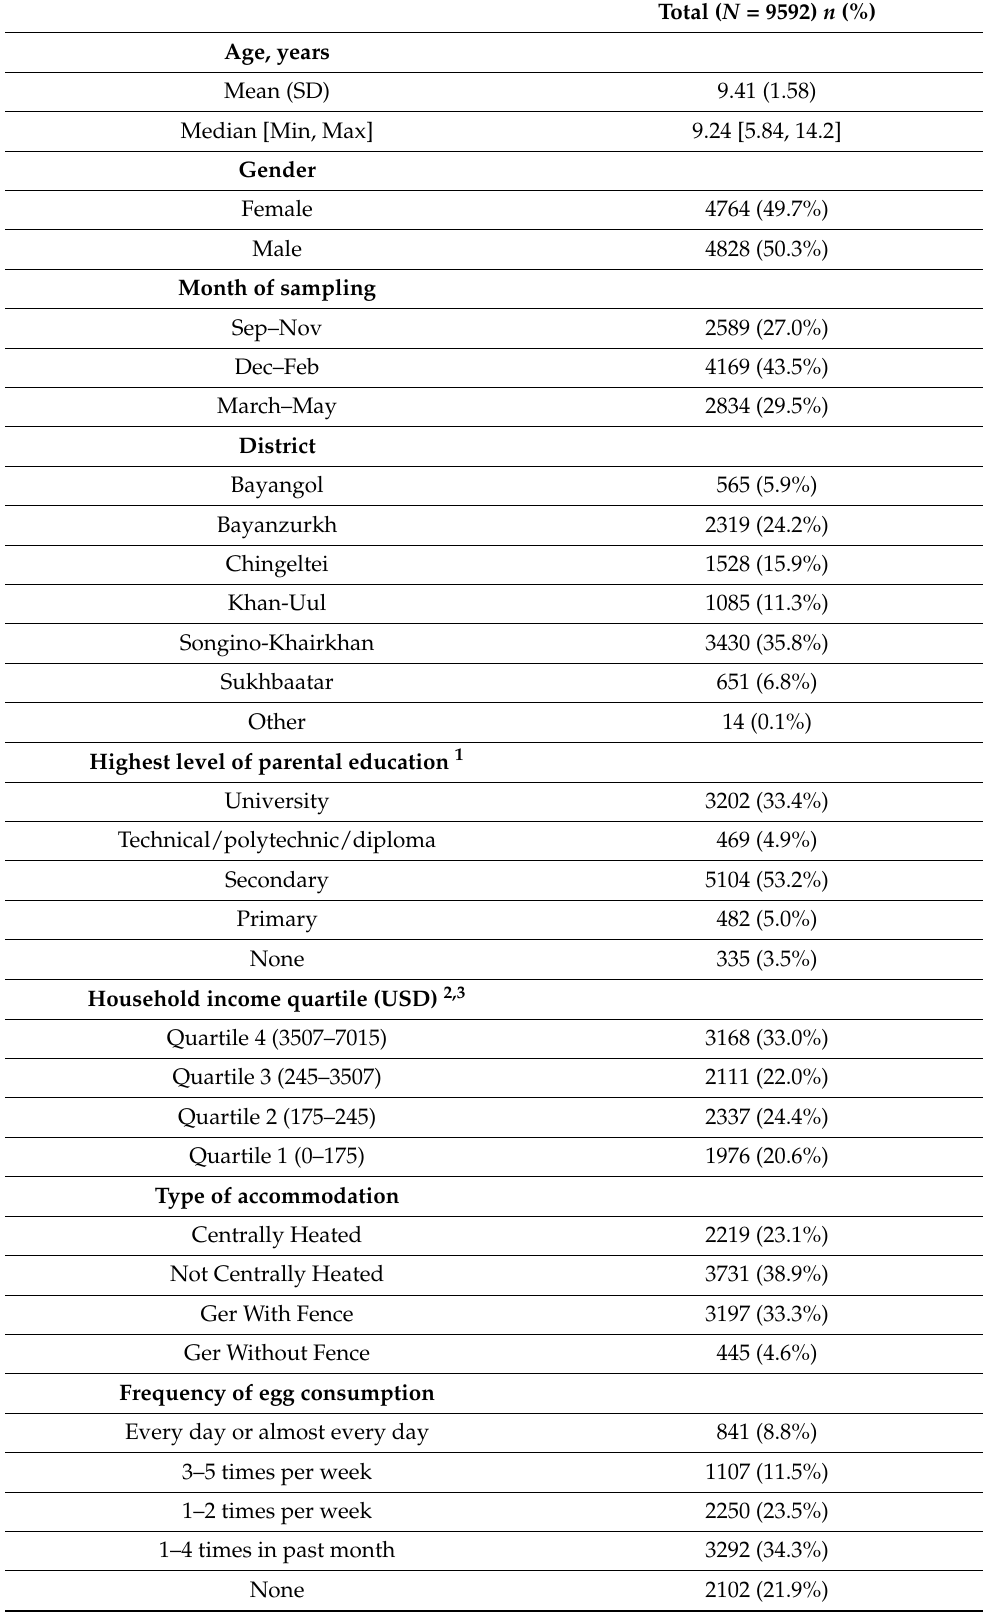
Table 1. Characteristics of Study